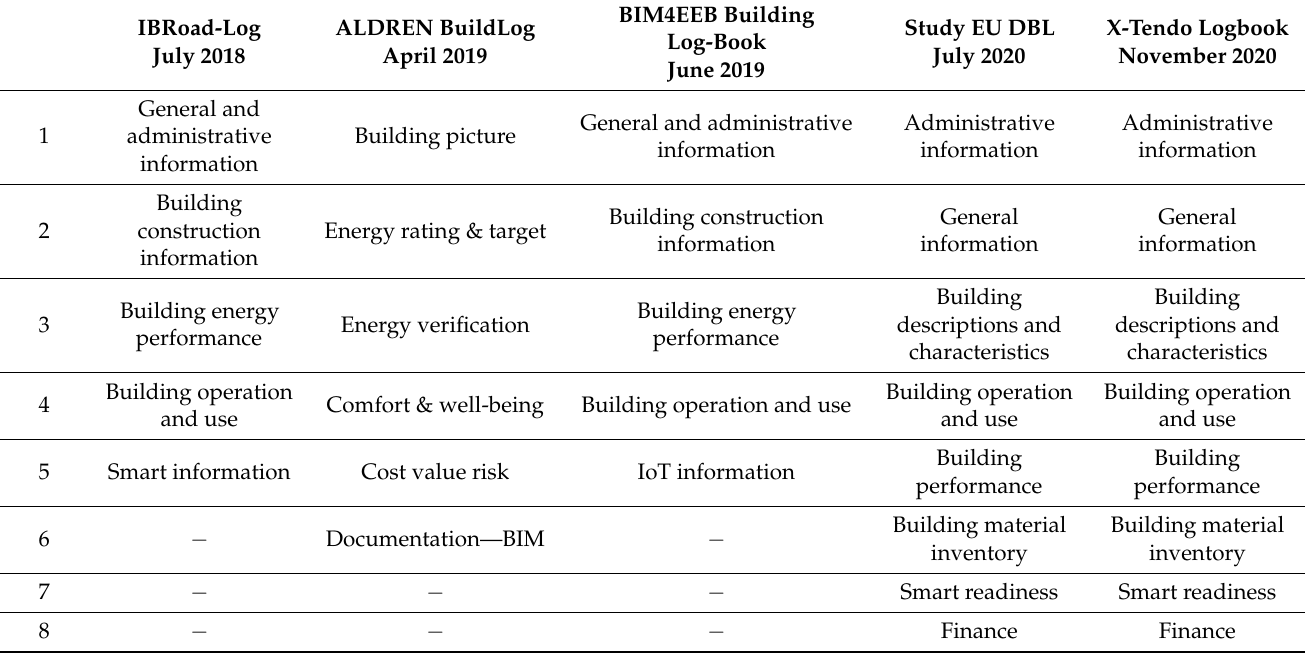
Table 2. Comparison of different elaborated existing DBL data